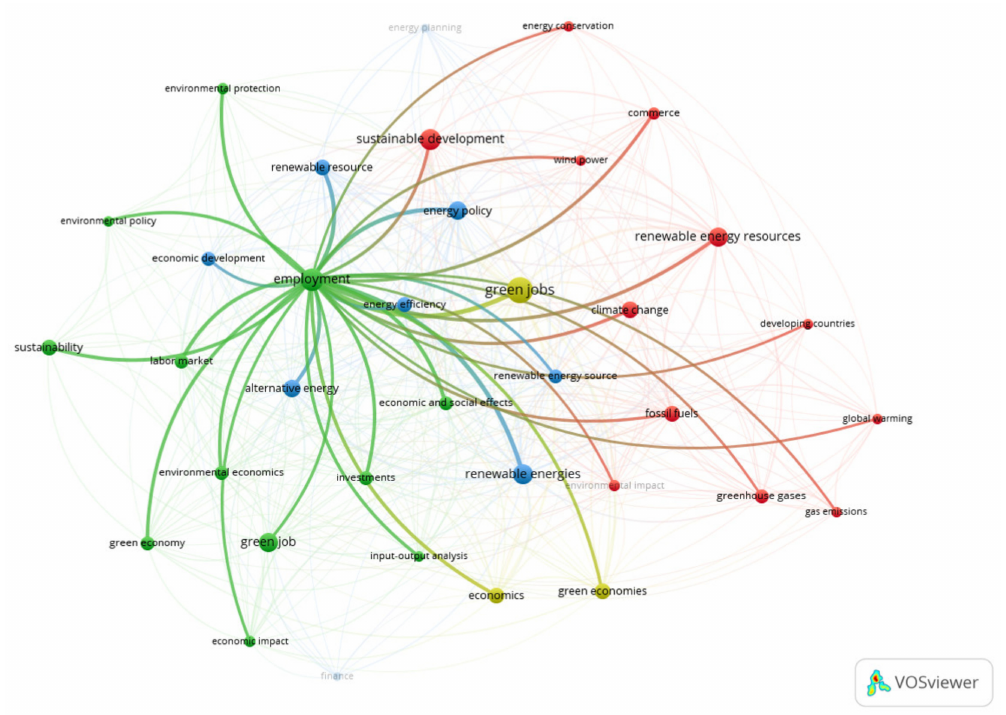
Figure 10. Keyword “employment” relations with other keywords. Source: Authors’ elaboration in VOSviewer software (1.6.18